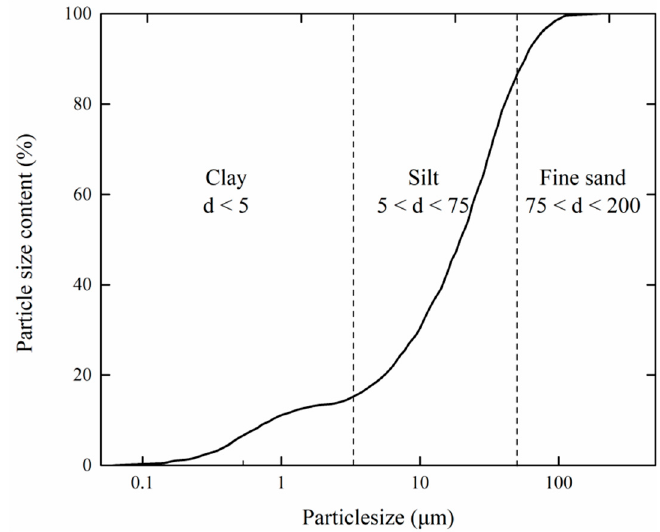
Figure 2. Soil sample particle grading curve.